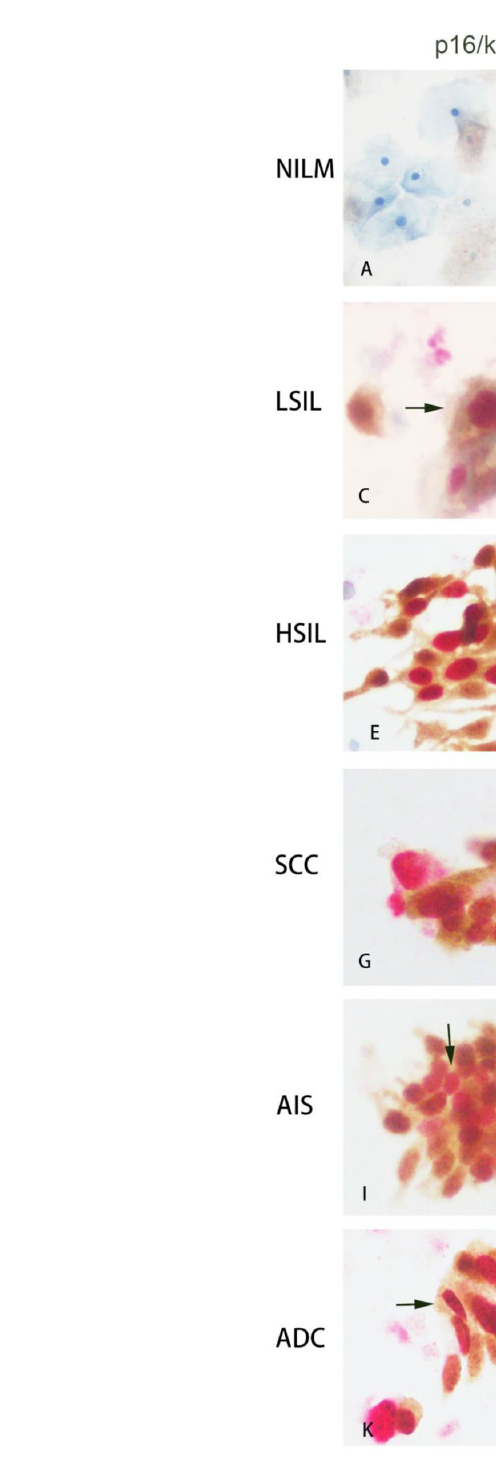
Frontiers in Oncology |